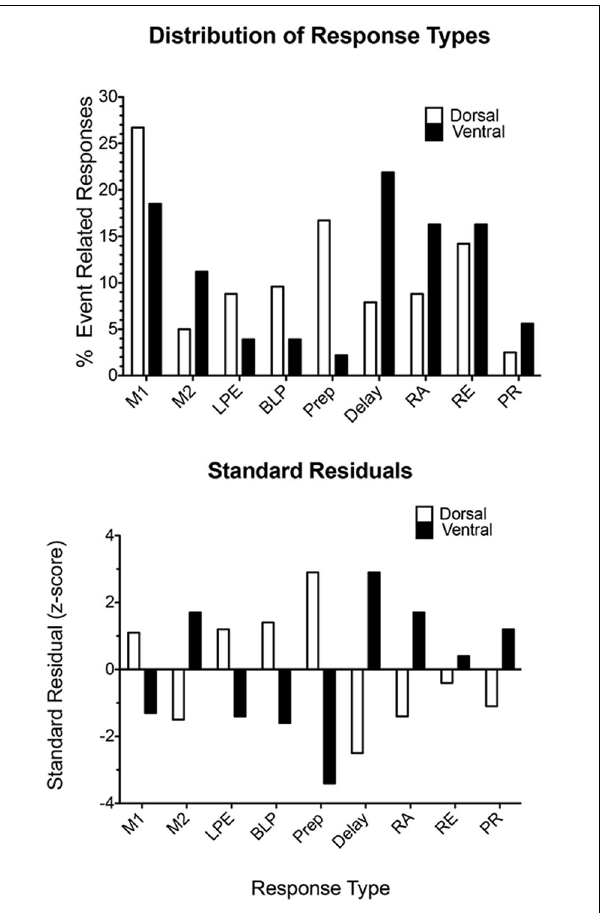
FIGURE 10 | Distribution of response types observed in dorsal and ventral areas of mPFC. The upper plot compares the percent of responses in each compartment exhibiting each of the most common response types observed during dDNMTP. The lower plot shows standard residuals indicating the contributions of each response type to the significant chi-square comparing the distribution of different response types in dorsal and ventral mPFC. Abbreviations are the same as for Figure 11 . Figure is reproduced from Francoeur and Mair